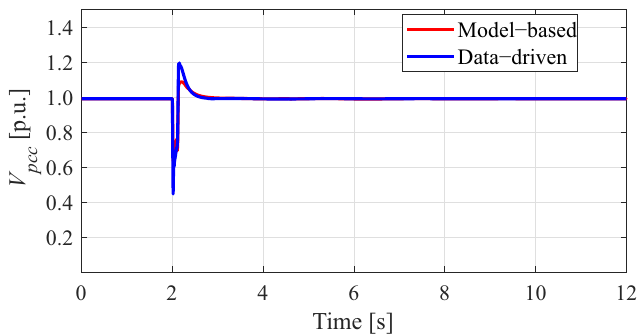
Figure 12. AC voltage during a fault on the transmission line.